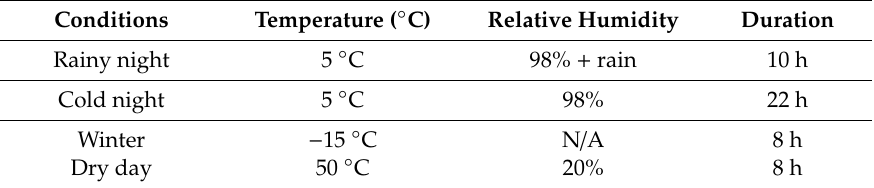
Table 5. Conditions of one cycle of artificial aging.